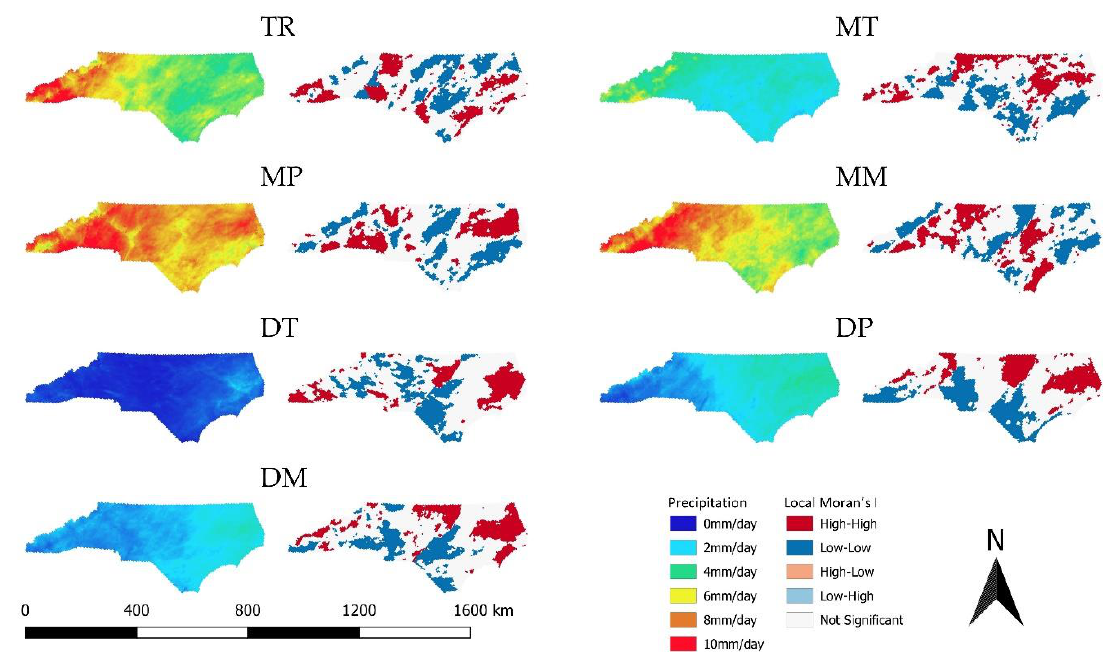
Figure 7. Spring (MAM) daily average precipitation ( left ) and spatial clustering analysis of precipitation Figure 7. Same as Figure 5 but for spring (MAM). ( right ) for each SSC air mass